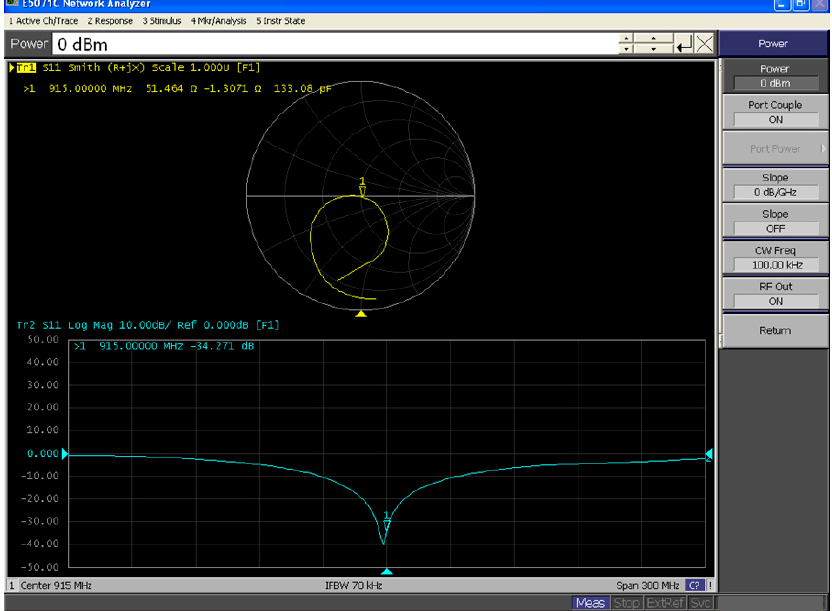
Figure 18. Measured results in the Z-smith chart at an input power of 0 dBm and RF of 915.0000 MHz.